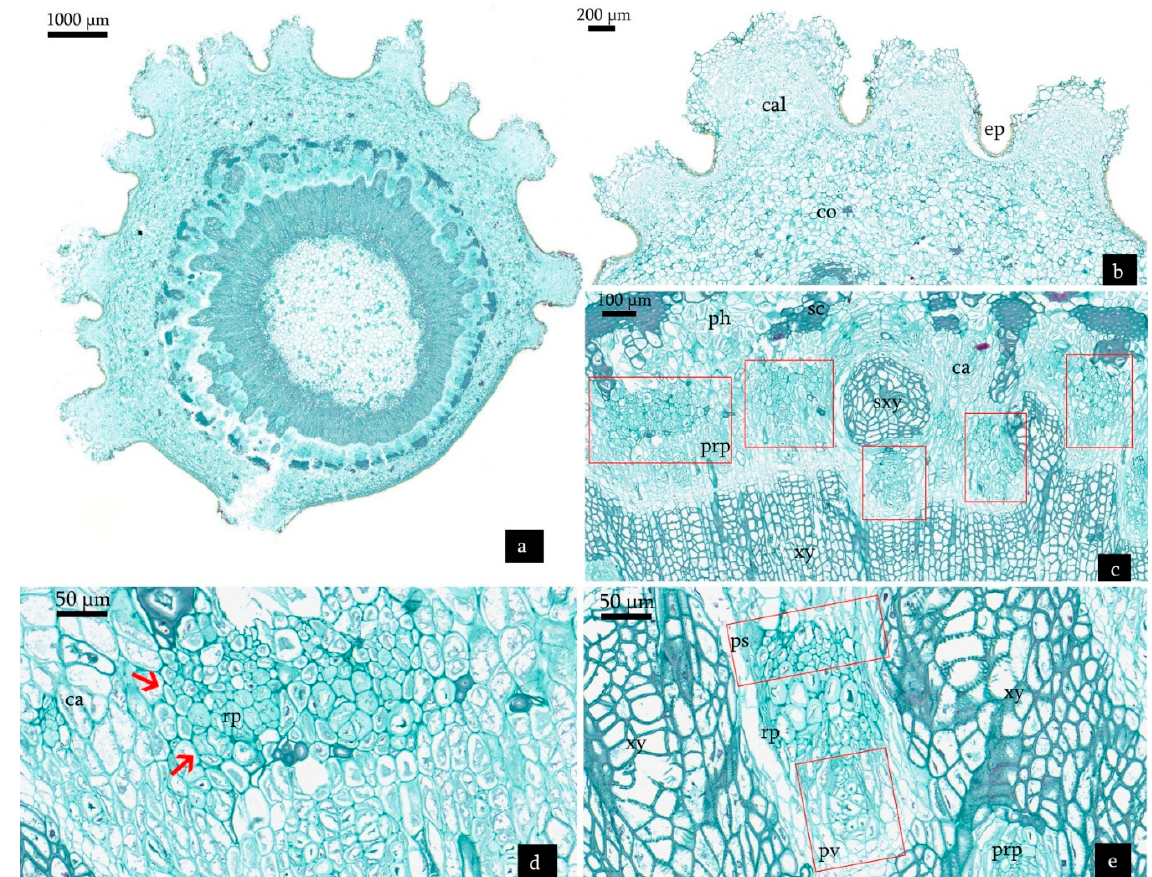
Figure 7. Transverse sections derived from cuttings treated with NAA:IBA (2:1) on the 18th day after planting. ( a ) Histological structure of cuttings treated with NAA:IBA (2:1) on the 18th day after planting. ( b ) Increased number of callus tissue on epidermis. ( c ) Increased number of precursors of adventitious root primordia. Red frame shows precursors of root primordia. ( d ) With cell proliferation and division, some precursors of root primordia became true root primordia. Arrows showing root primordia. ( e ) Root primordia (dome-like structures) in differentiation. Red frame shows the procambium strand and precursors of vascular tissues. Abbreviations: ep = epidermis; co = cortex; sc = sclerenchyma; ph = phloem; ca = cambium; xy = xylem; prp = precursor of adventitious root primordia; sxy = scattered xylem; cal = callus tissue; pv = precursors of vascular tissue; rp = root primordium; ps = procambium